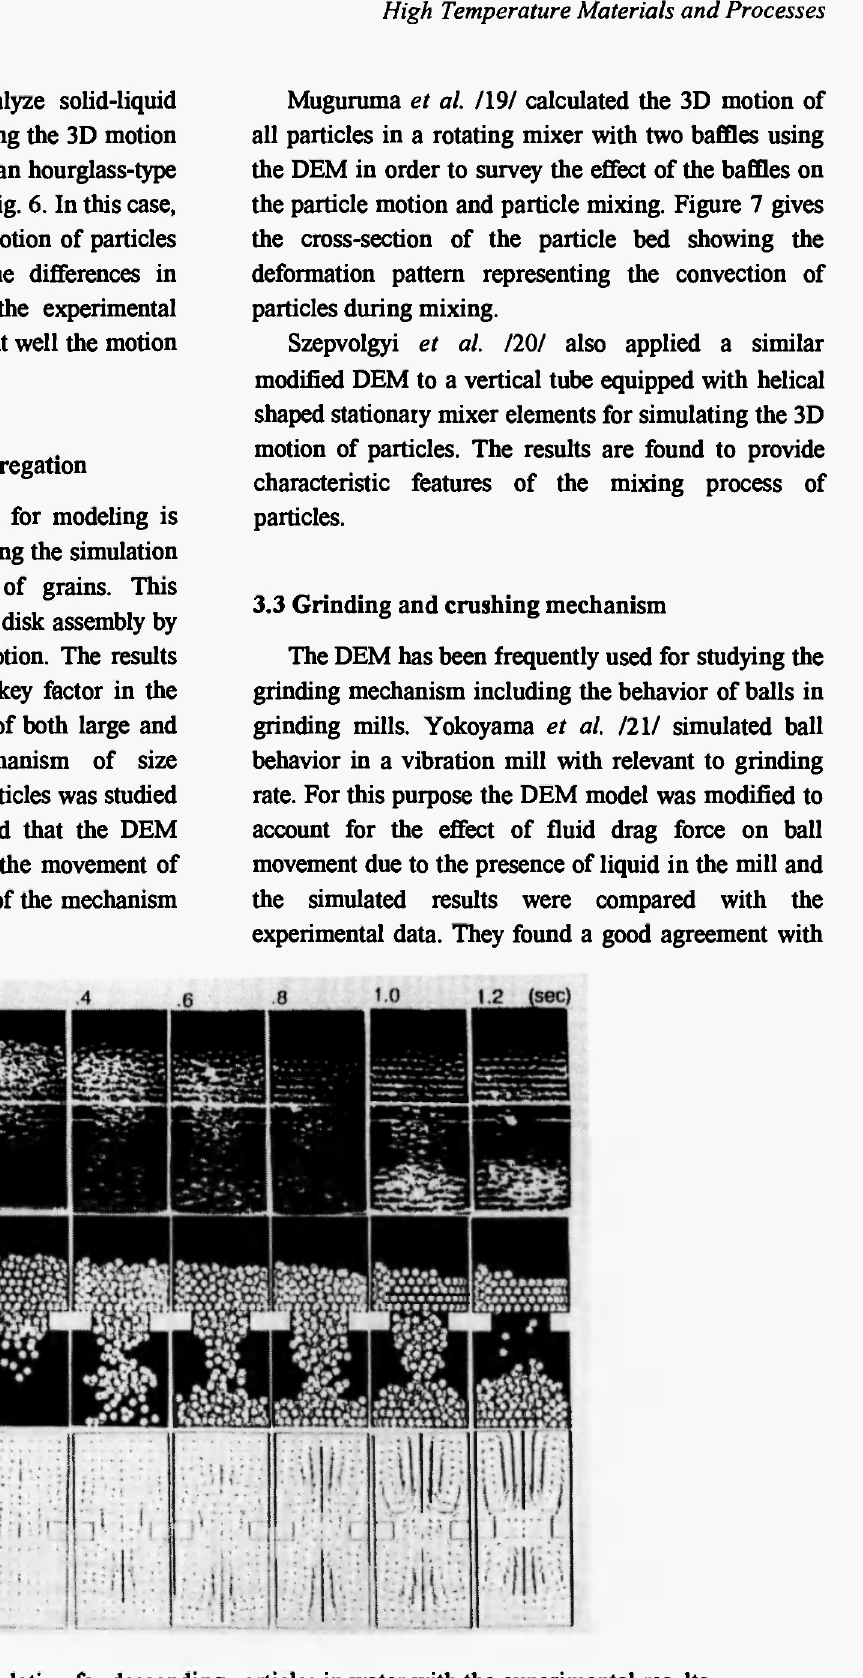
Fig. 6: Comparison of simulation for descending particles in water with the experimental